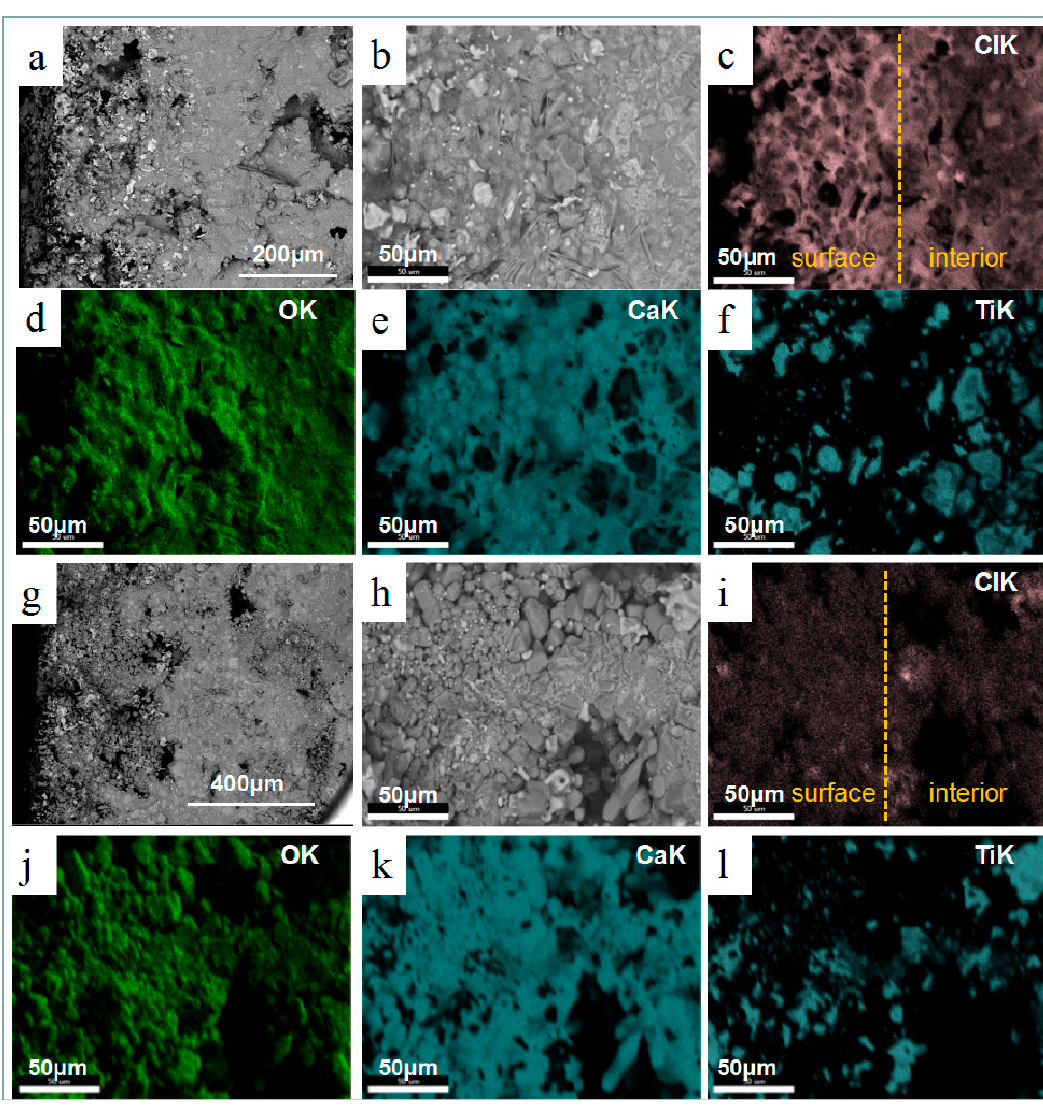
Figure 7. SEM images and corresponding map ‐ scan of products with different reduction time at 1273 K: ( a , b ) reduction product for 30 min; ( c – f ) distribution of element of ( b ); ( g , h ) reduction product for 1 h; ( i – l ) distribution of element of ( h ).